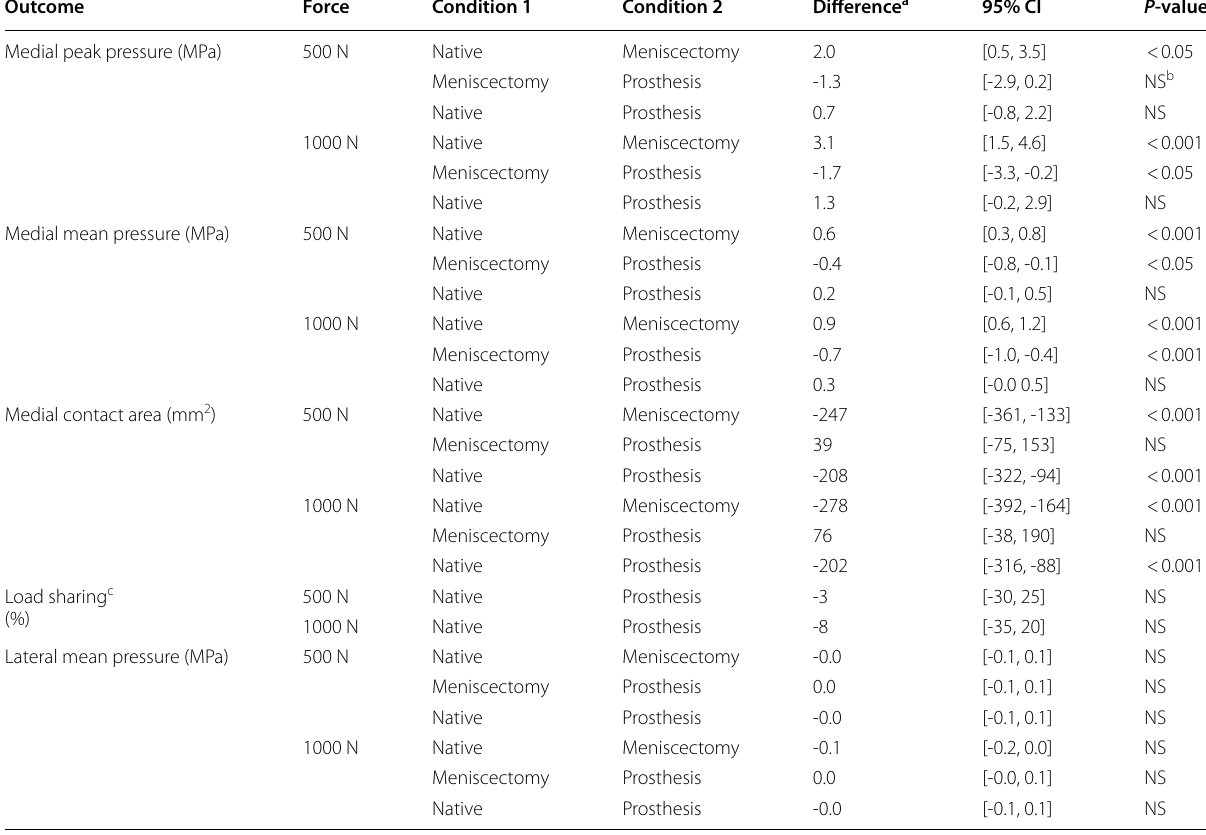
a Mean difference between condition 1 and 2: A positive difference means an increase from condition 1 to condition 2 b Not significant, meaning p > 0.05 c Percentage of medial compartment load transferred through the